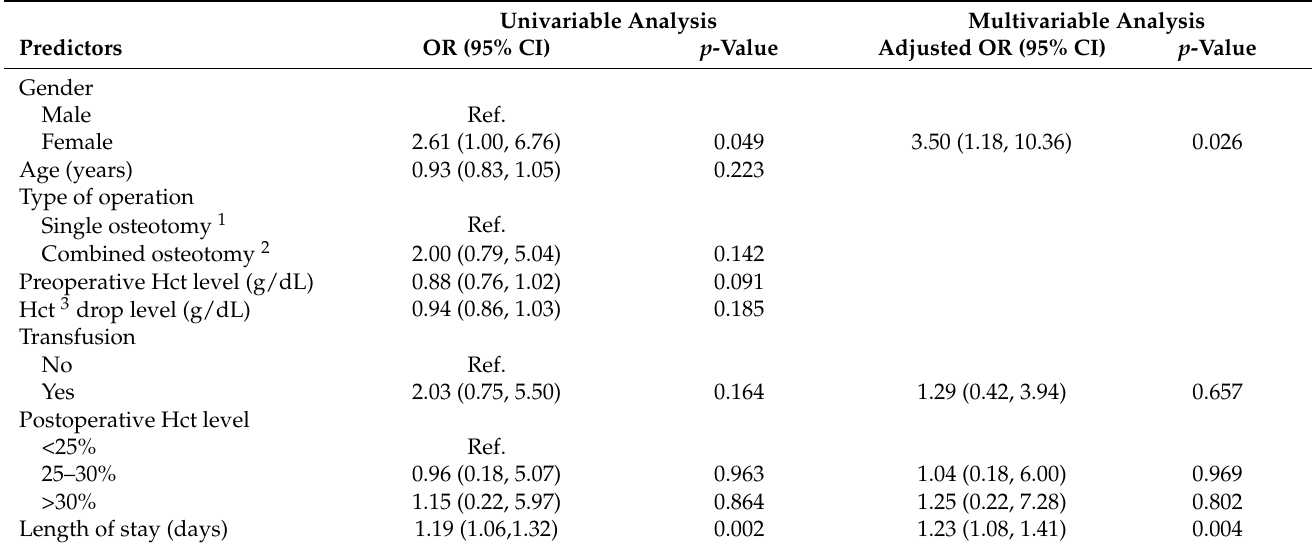
Table 5. Univariable and multivariable logistic regression analysis of postoperative complications after pediatrics hip